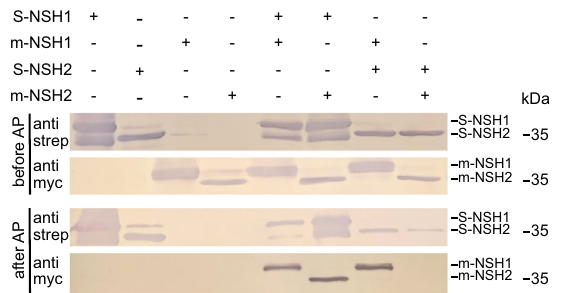
Fig. 3 | Interaction of NSH1 and NSH2 from Phaseolus vulgaris. NSH1 and NSH2 weretransiently(co)-expressedasmyc-orStrep-taggedvariantsin N.benthamiana . N-terminal tagged proteins were af fi nity puri fi ed using the Strep tag. Protein expression (top two panels) and protein (co)-puri fi cation by af fi nity chromato- graphy (bottom two panels) were assessed by immunodetection with either Strep- Tactin alkaline phosphatase conjugate (anti strep) or anti c-myc (anti myc) anti- bodies. 10 µ l of clari fi ed leaf extracts or af fi nity-puri fi ed proteins were loaded. AP af fi nitypuri fi cation,pre fi xm-c-myc-tagged,pre fi xS-Strep-tagged.Theexperiment was performed three times with similar results.